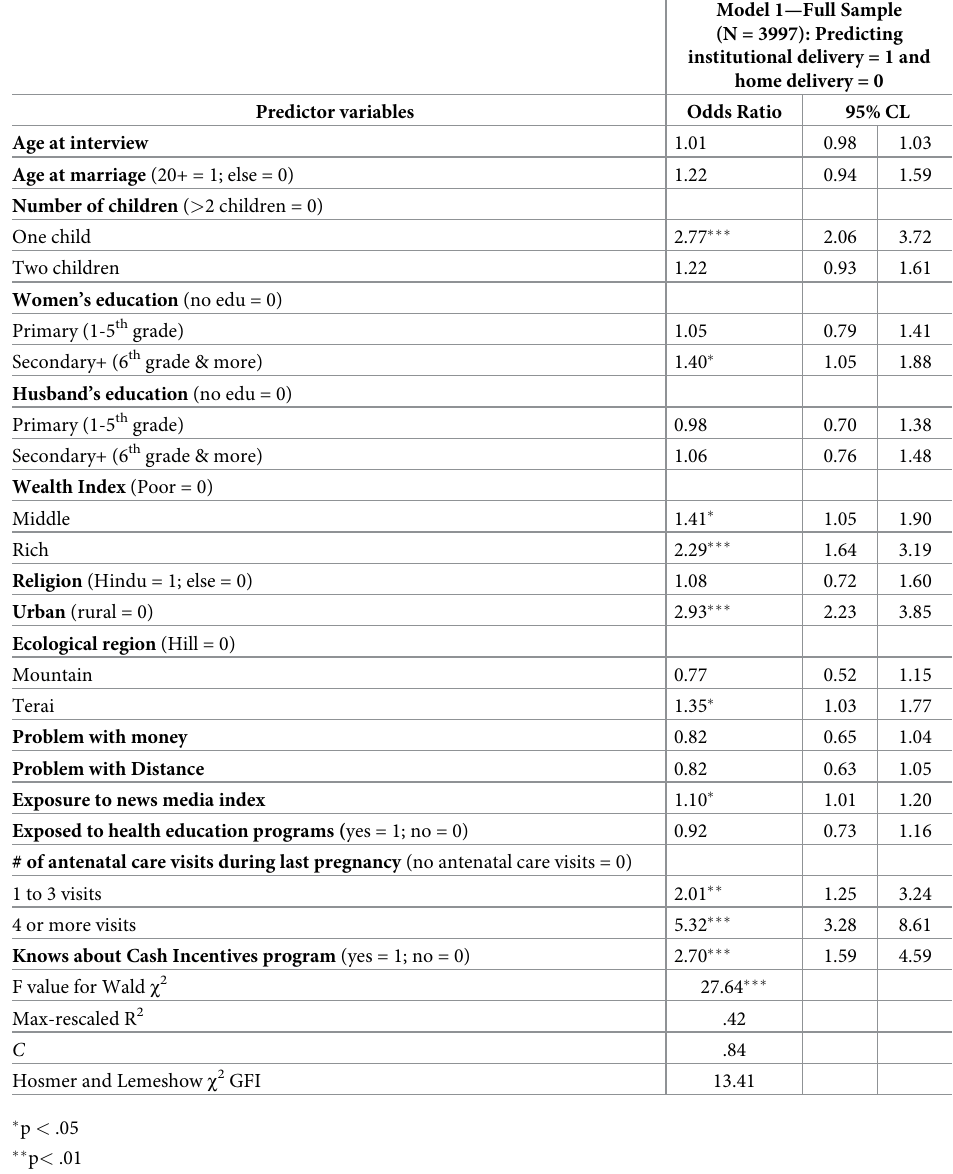
Table 3. Odds ratio predicting likelihood of women delivering at an institution in Nepal, 2011.